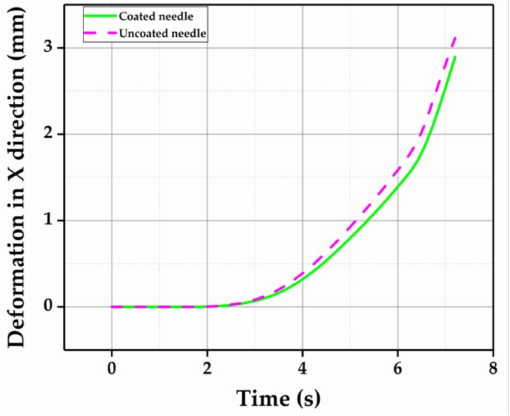
Figure 15. The deformation in the x direction at the maximum stress